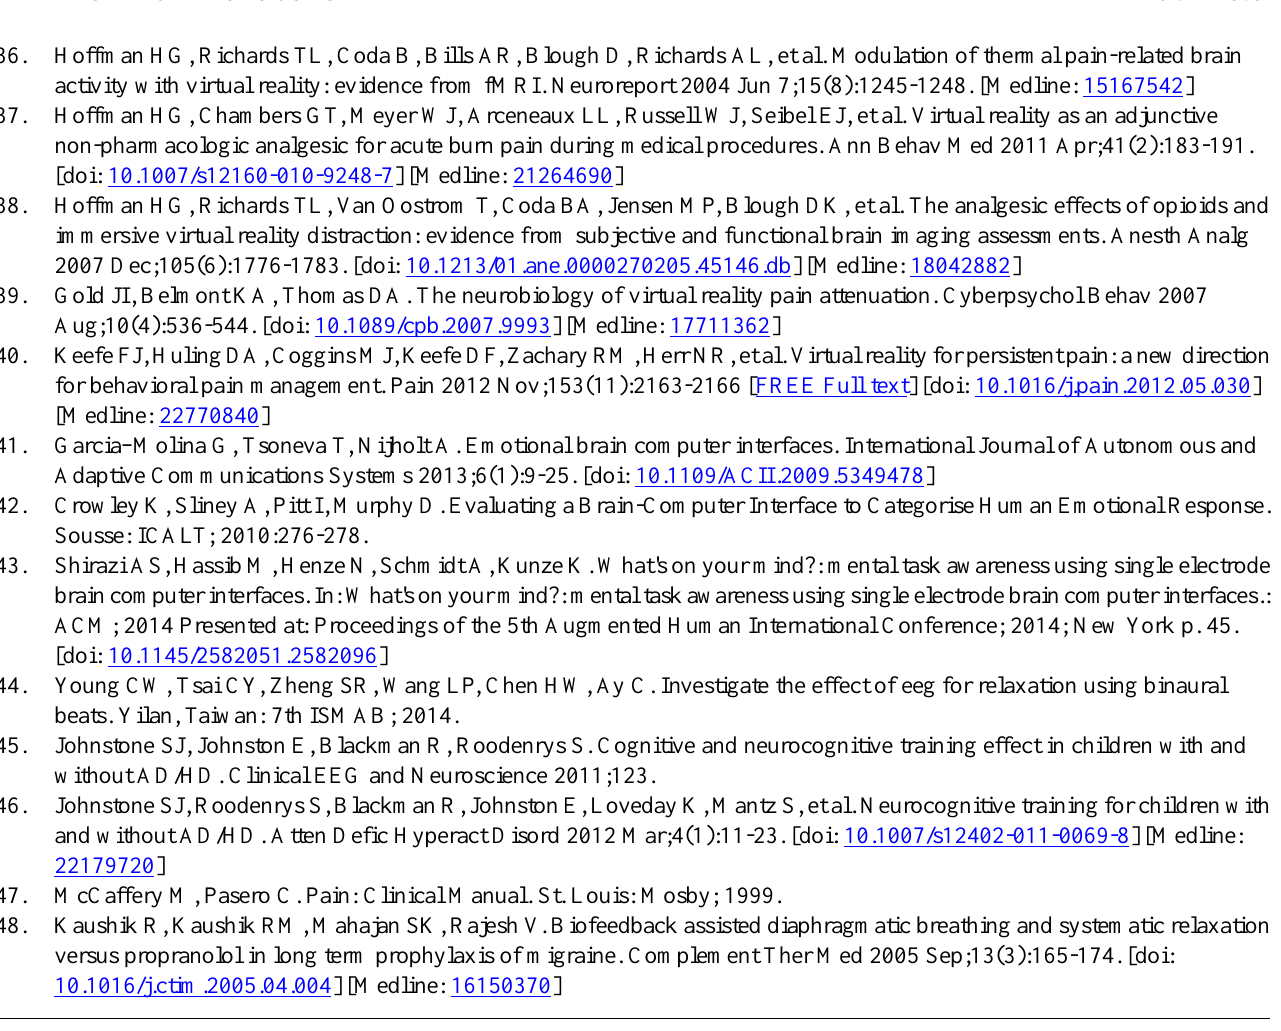
Abbreviations BCl: Brain-computer